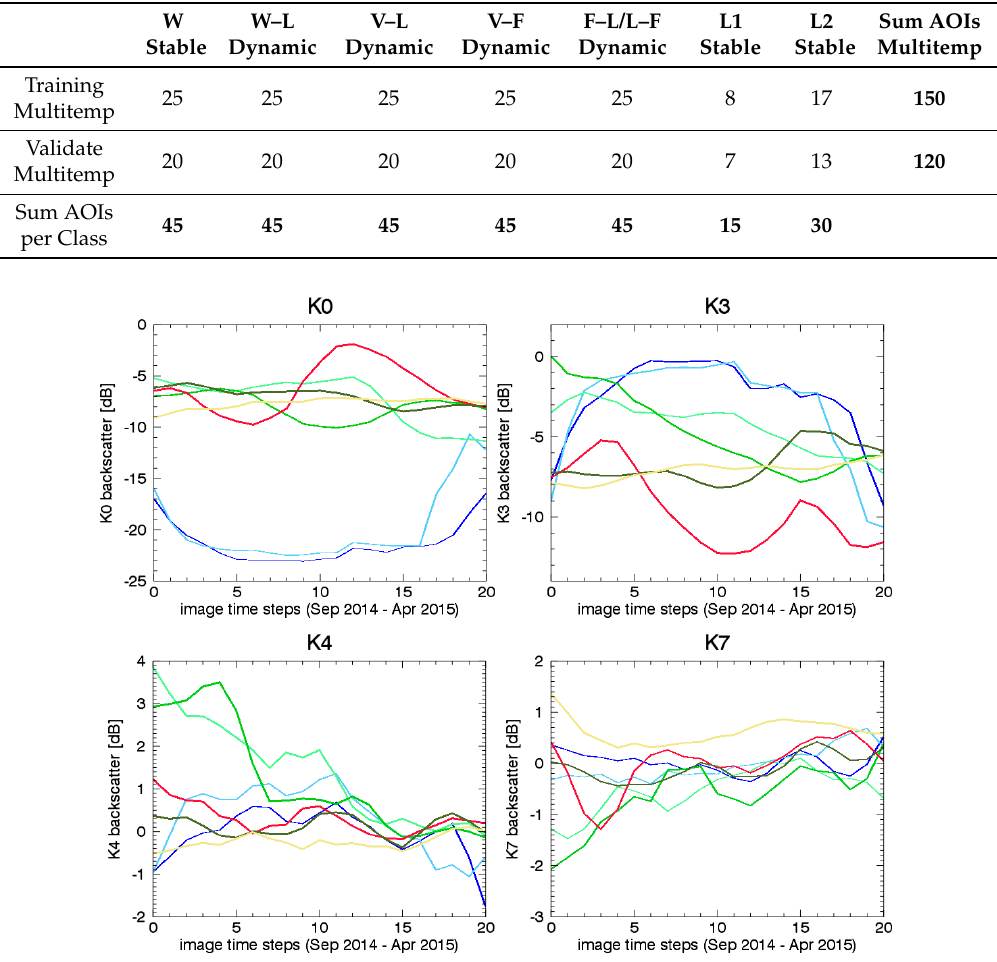
Figure 6. Temporal signature analysis from September 2014 until April 2015 for the Kennaugh elements K 0 , K 3 , K 4 , and K 7 : W (dark blue); W–L (light blue); V–L (light green); V–F (green); L–F/F–L (dark red); L1 (dark green); L2 (beige).